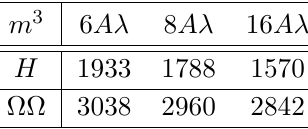
Table 13 . Masses of H-dibaryon and di-Omega by using (5.12) with (5.18) and (5.19).